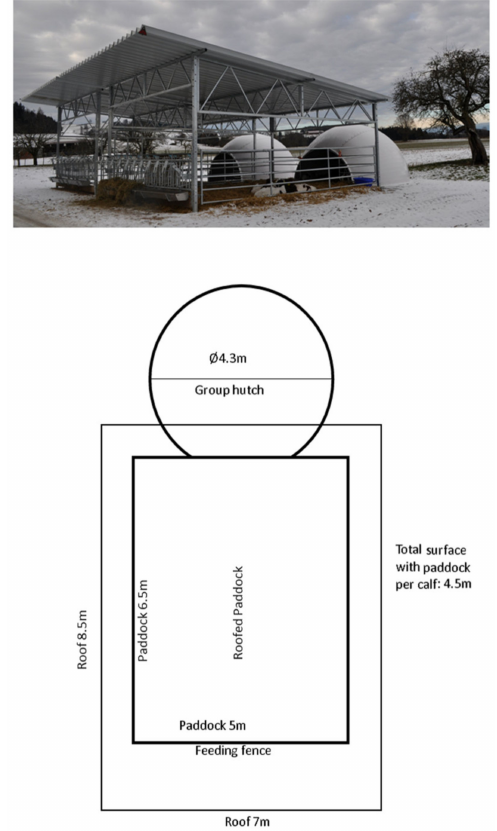
Figure 1. Illustration and dimensions of group hutches in the "outdoor veal calf"